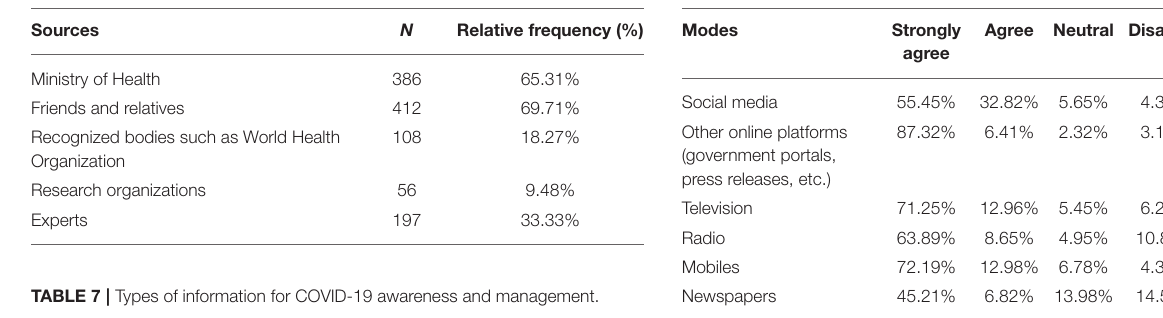
TABLE 8 | Communication channels for creating